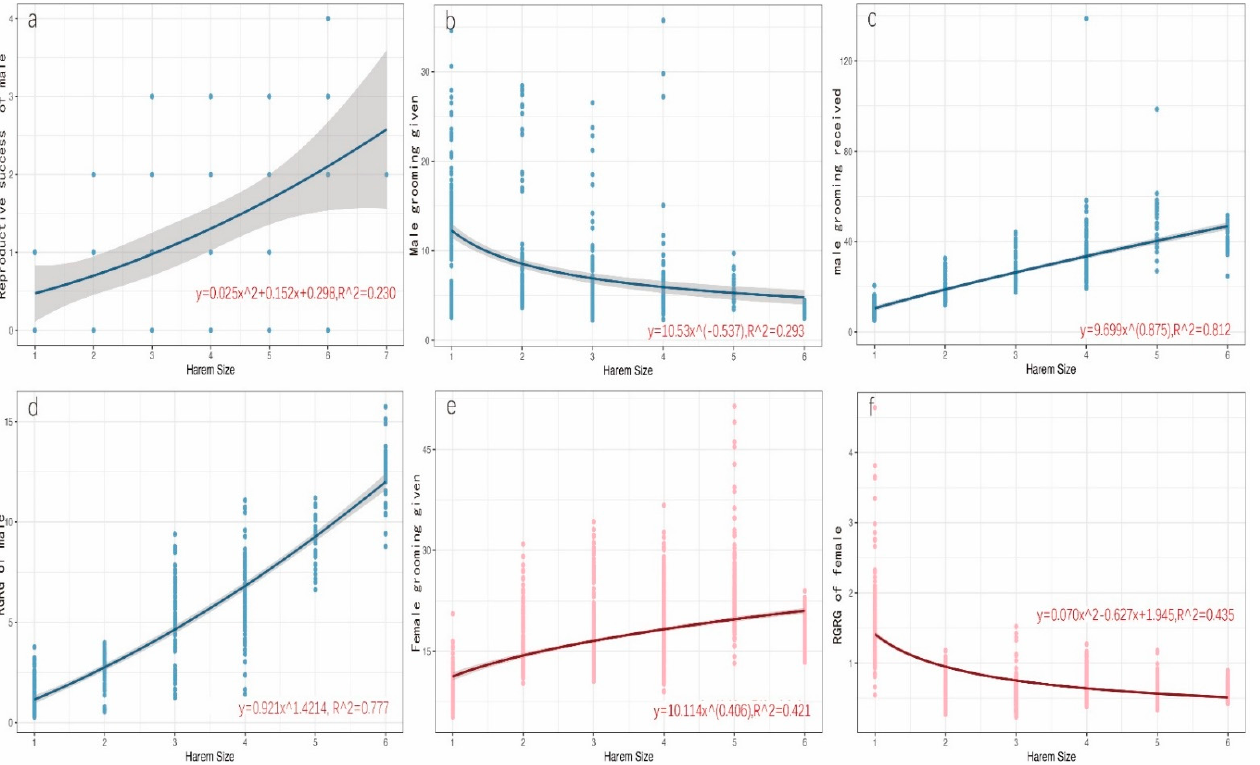
Figure 1. Relationships between harem size and reproductive success as well as grooming given, received, and the ratio of grooming received to given. ( a ) Reproductive success of harem holder and harem size, ( b ) Grooming given by harem holders and harem size, ( c ) Grooming received by harem holders and harem size, ( d ) The ratio of grooming received to given for harem holders and harem size, ( e ) Grooming given by females and harem size, and ( f ) The ratio of grooming received to given (RGRG) for females and harem size.